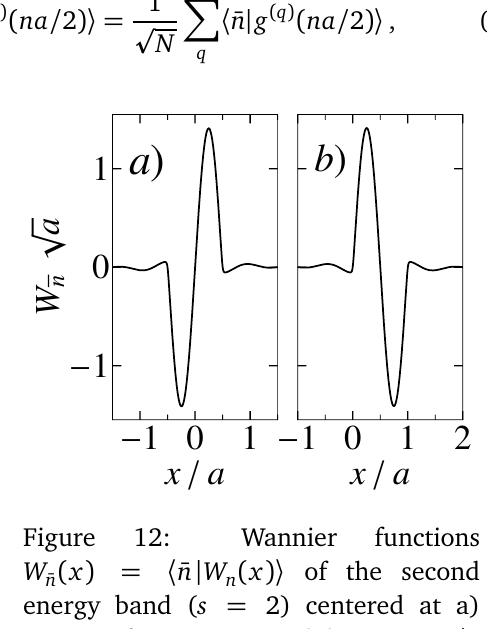
Figure 11: Wannier functions Figure 12: Wannier functions ( x ) = 〈 ¯ n | W ( x ) 〉 of the first en- ( x ) = 〈 ¯ n | W ( x ) 〉 of the second W W n n ¯ n ¯ n ergy band ( s = 1) centered at a) x = 0 energy band ( s = 2) centered at a) x = 0 for n = 0 and b) x = a / 2 for n = 0 and b) x = a / 2 for n = 1. = 8000 E Parameters are ε = 0.1, Ω , for n = 1. Parameters are ε = 0.1, p R ∆ = Ω Ω = 8000 E and α = 10 ◦ . , ∆ = Ω and α = 10 ◦ p p R p